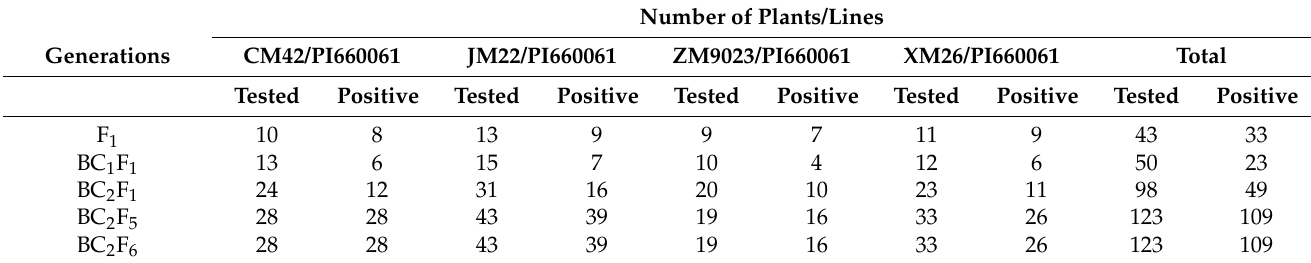
Table 2. Numbers of progeny plants (for F 1 , BC 1 F 1 and BC 2 F 1 ) or lines (BC 2 F 5 and BC 2 F 6 ) tested and positive for Yr59 -linked SSR markers in different generations derived from wheat crosses of four elite cultivars (CM42, JM22, ZM9023 and XM26) with Yr59 donor PI 660061). The F 1 , BC 1 F 1 , BC 2 F 1 generations were screened with Xbarc32 , and BC 2 F 5 and BC 2 F 6 were screened with Xbarc32 ,